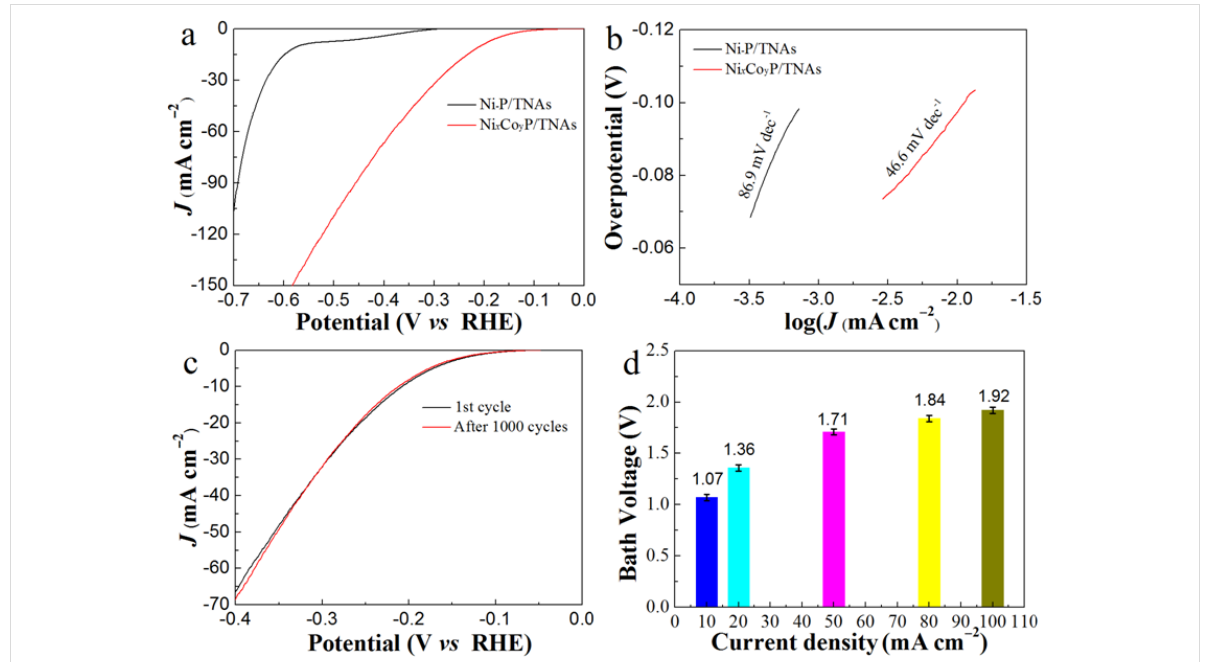
Figure 6: (a) Current–voltage characteristic plots and (b) Tafel plots of the samples. (c) Current–voltage characteristics during durability tests and (d) bath voltages at various current densities for the two-electrode system with Ni x Co y P/TNAs as a cathode.